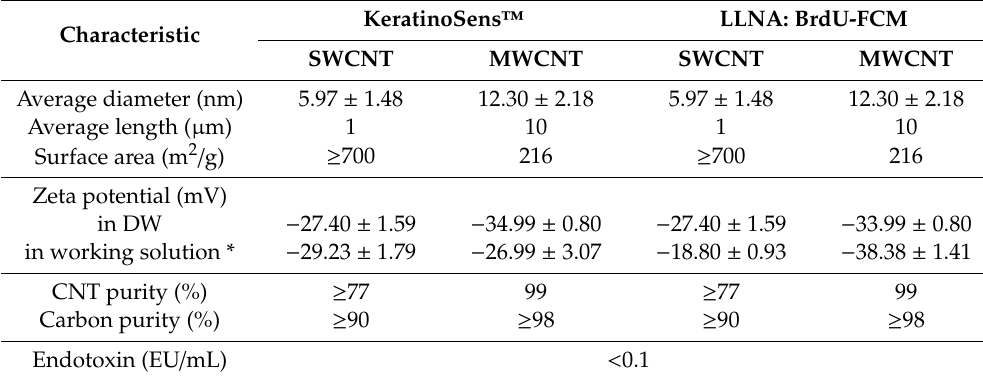
Figure 1. Transmission electron microscopy images of the ( A ) single-wall carbon nanotubes (SWCNTs) (bar = 20 nm) and ( B ) multi-walled carbon nanotubes (MWCNTs) (bar = 50 nm) in distilled water. Table 1. Characteristics of SWCNTs and MWCNTs.